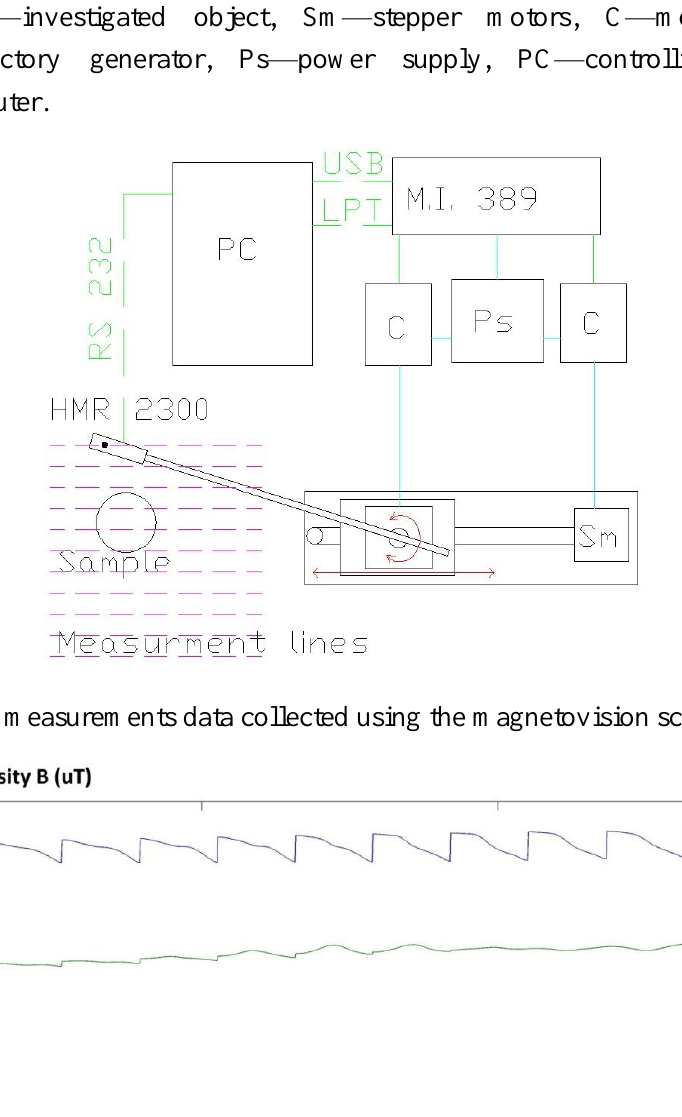
(Figure 3). Visualization of the distribution of the magnetic induction vector absolute values, interpolated to 1000 × 1000 points resolution, is also possible (Figure 4). Figure 1. Schematic block diagram of the measuring system: HMR 2300—magnetoresistive